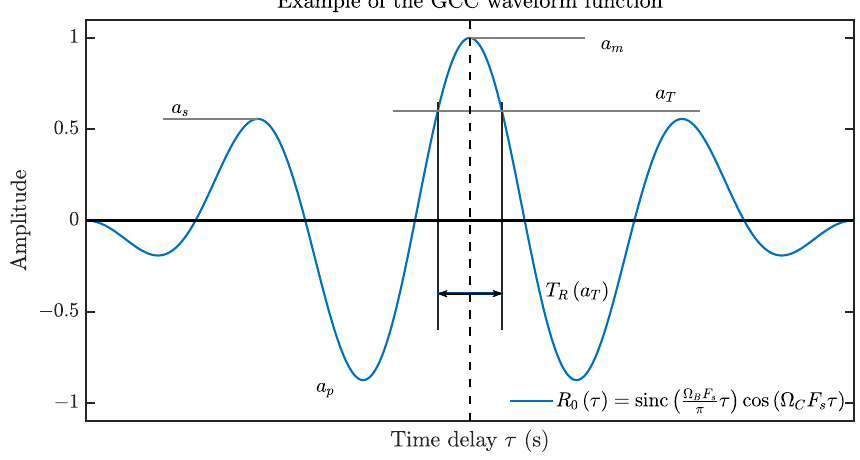
Figure 3. An example of R 0 ( τ )